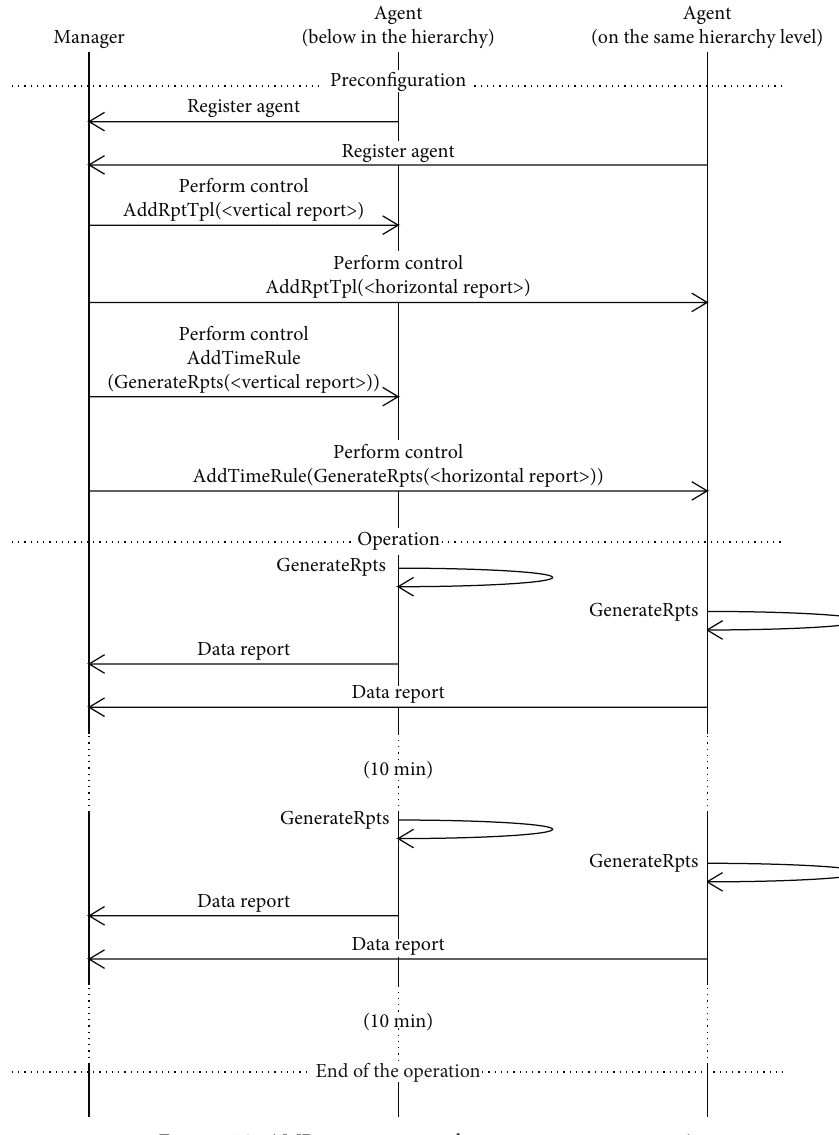
Figure 10: AMP messages sent by our management